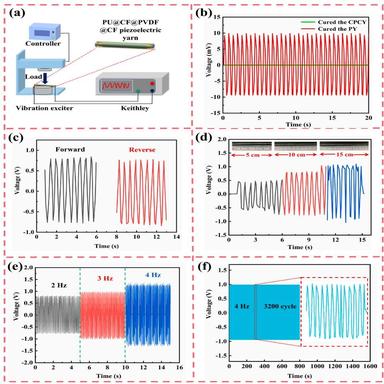
(a) Schematic illustration of electrical signal testing equipment. (b) Electrical signals generated by CPCY and PY after curing. (c) The voltage output diagram after the electrodes are connected forward and reversely. (d) Output voltage curves at different lengths. (e) Output voltage of PVDF piezoelectric yarn sensor under various loading frequencies using a constant pressure force of 10 N. (f) Cyclic stability of the piezoelectric yarns during 800 s.